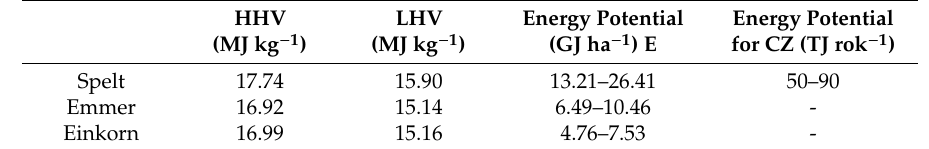
Table 6. Energy parameters of hulled wheat cha ff .